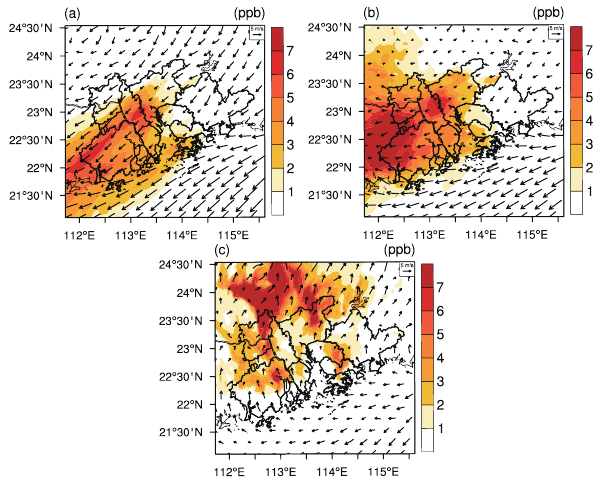
Fig. 9. Spatial distributions of the surface ozone peak changes due to BVOC emissions under different meteorological conditions: (a) north wind condition; (b) calm wind condition; (c) south wind con- dition.